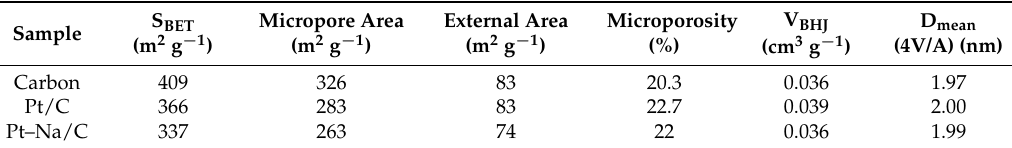
Table 2. Textural properties of the prepared samples.